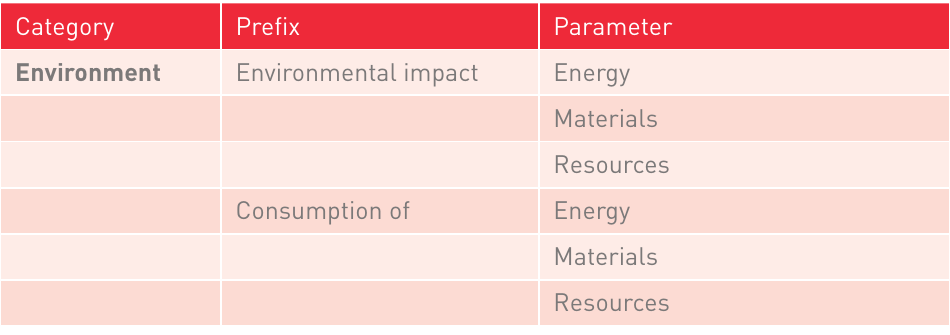
The parameters of sustainability and their categories (Birgisdottir, et al.